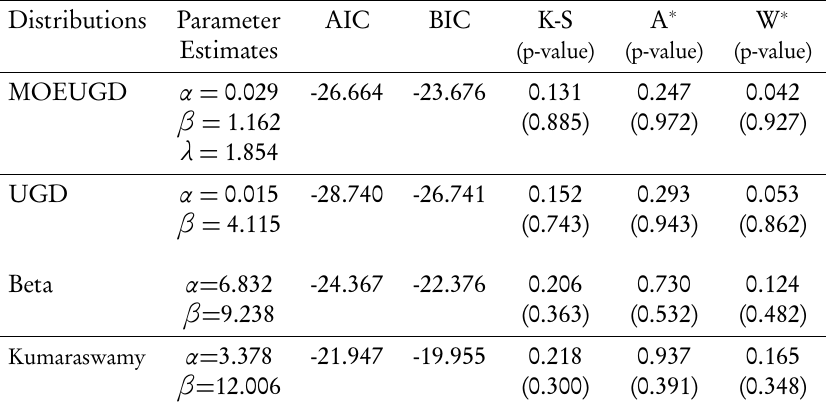
Summary Statistics for the Flood Level Data Set, n =